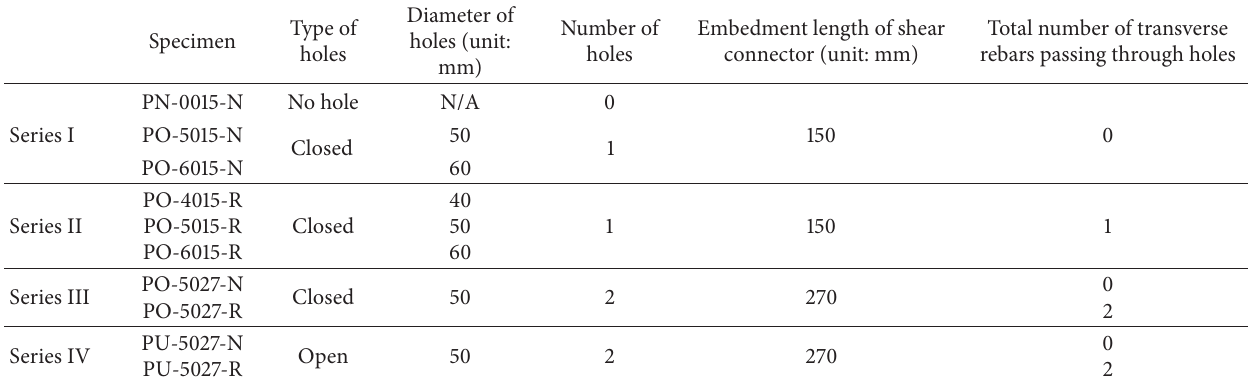
Table 1: Details of test